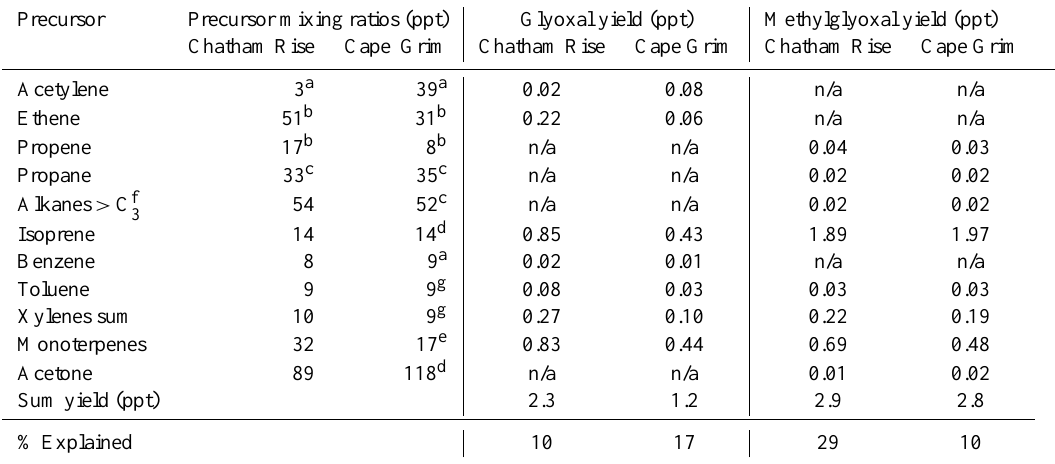
Where supplementary (e.g. non-parallel) measurements were used, these are denoted as follows: a Cape Grim flasks (NOAA HATS